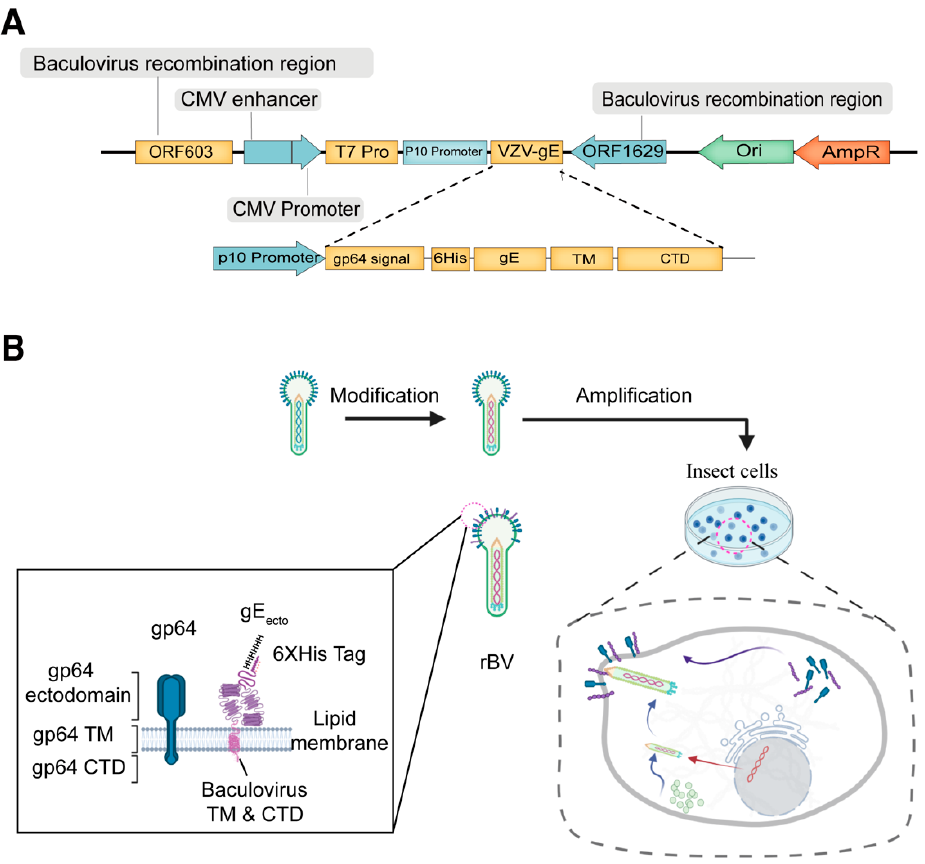
Figure 1. Construction of recombinant baculovirus displaying the gE protein. ( A ) A schematic illustration of the Varicella zoster virus (VZV) gE protein recombinant expression cassette. The coding sequences of the VZV–gE gene were cloned into the baculovirus vector, pTriEx-5, which contains the gene for the gp64 signal peptide (SP), a 6×His tag in the N-terminus, a transmembrane domain (TM) of gp64, and the cytoplasmic domain (CTD) of gp64 at the C-terminus of the cassette. ( B ) Flow chart of the budding process and amplification of the recombinant baculovirus (rBV) Bac–gE in Sf9 insect cells. The gE protein is displayed on the lipid membranes of cells. High titers of rBV are produced following several rounds of infection in Sf9